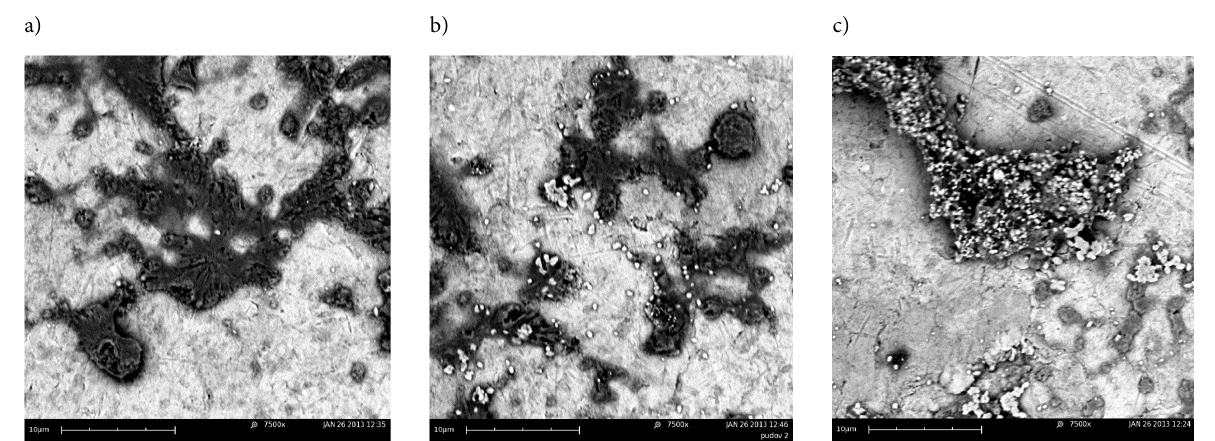
Fig. 4. Curves of DSC suspension treated for 2 hours in mixer Fig. 5. Curves of DSC suspension treated for 6 hours in mixer